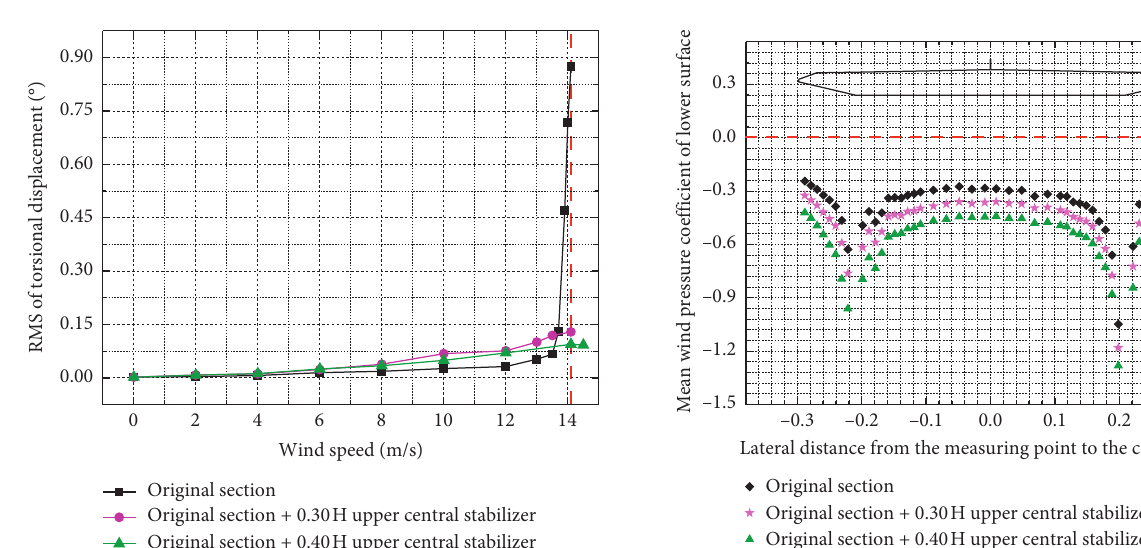
Figure 8: Torsional displacements for different aerodynamic measures.